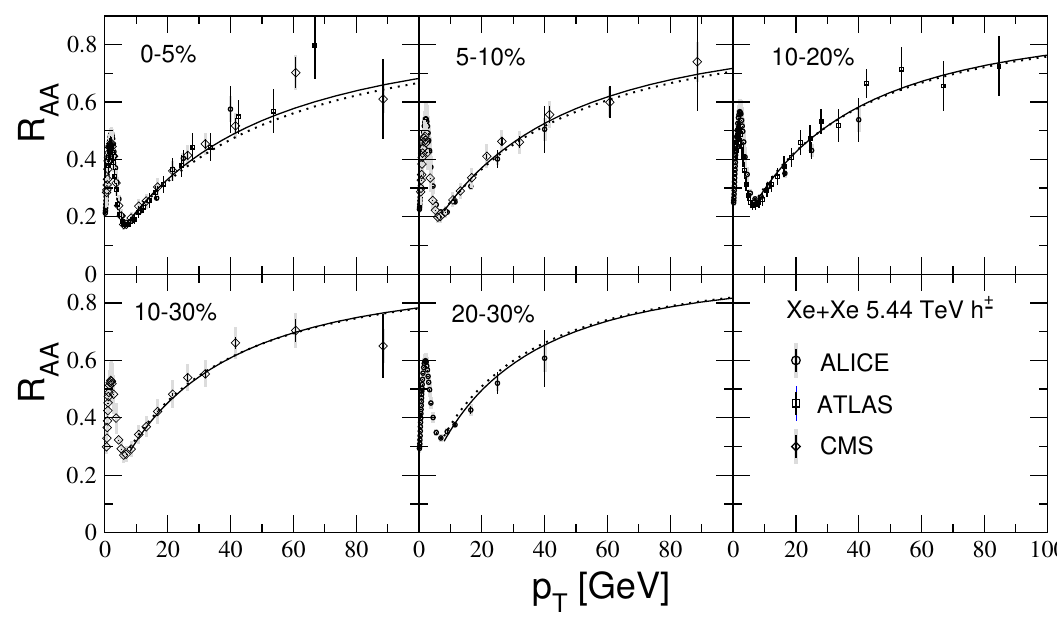
Figure 6 . Same as in figure 4 for 5 . 44 TeV Xe+Xe collisions for the optimal parameters κ = 3 . 59 and 2 . 52 . Data points are from ALICE [81], ATLAS [82], and CMS